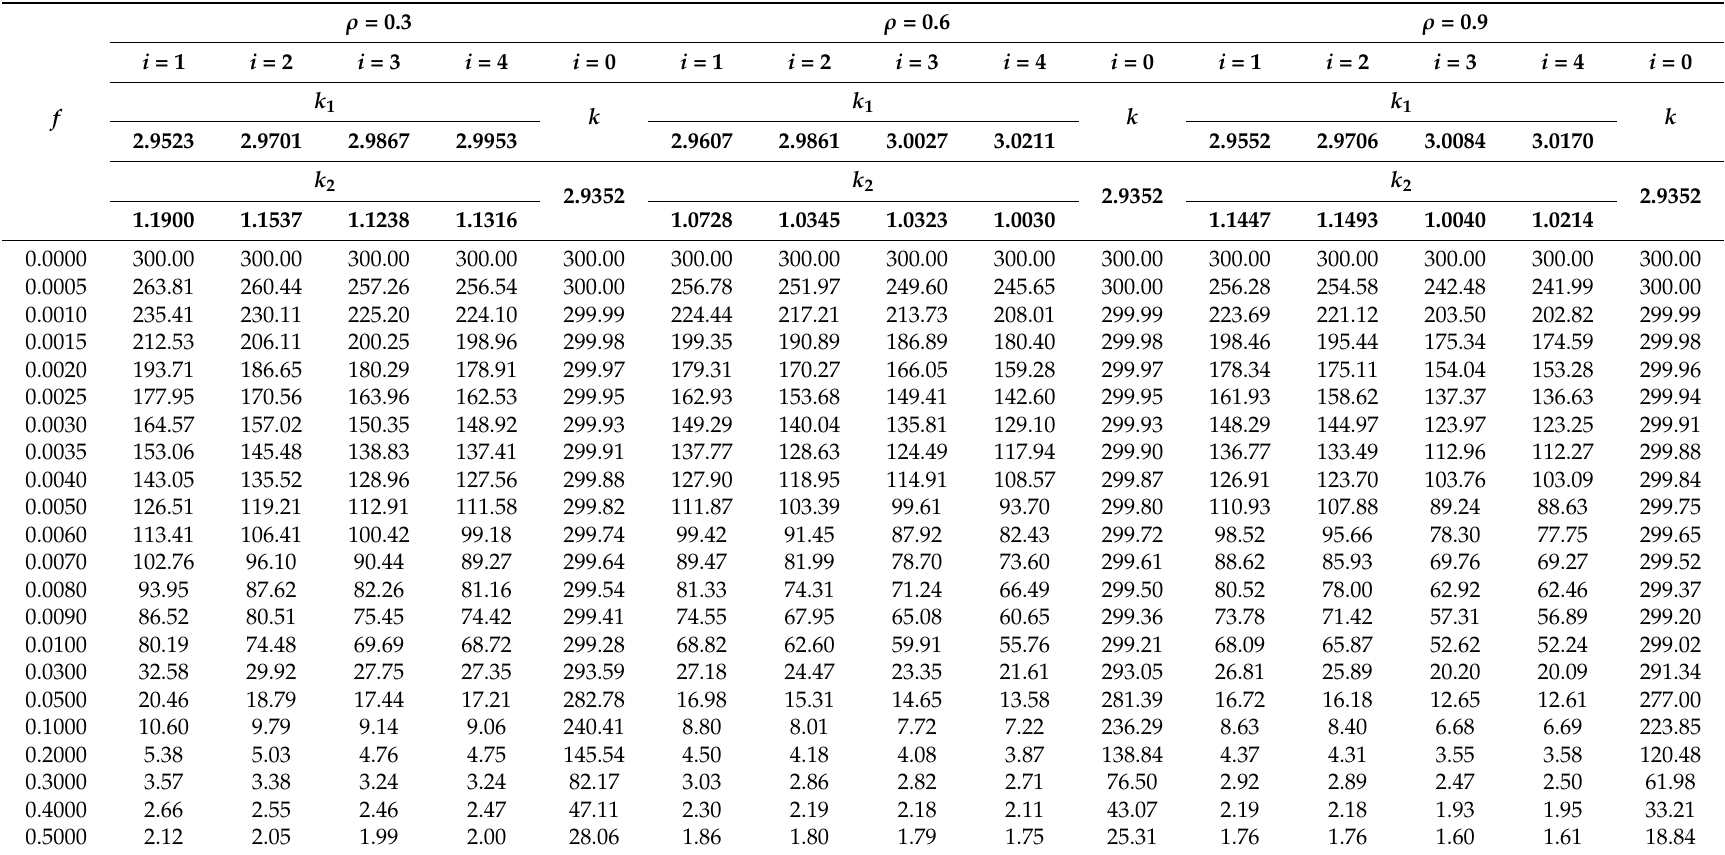
Table 1. The average run length ( ARL ) analysis for 300 with n =